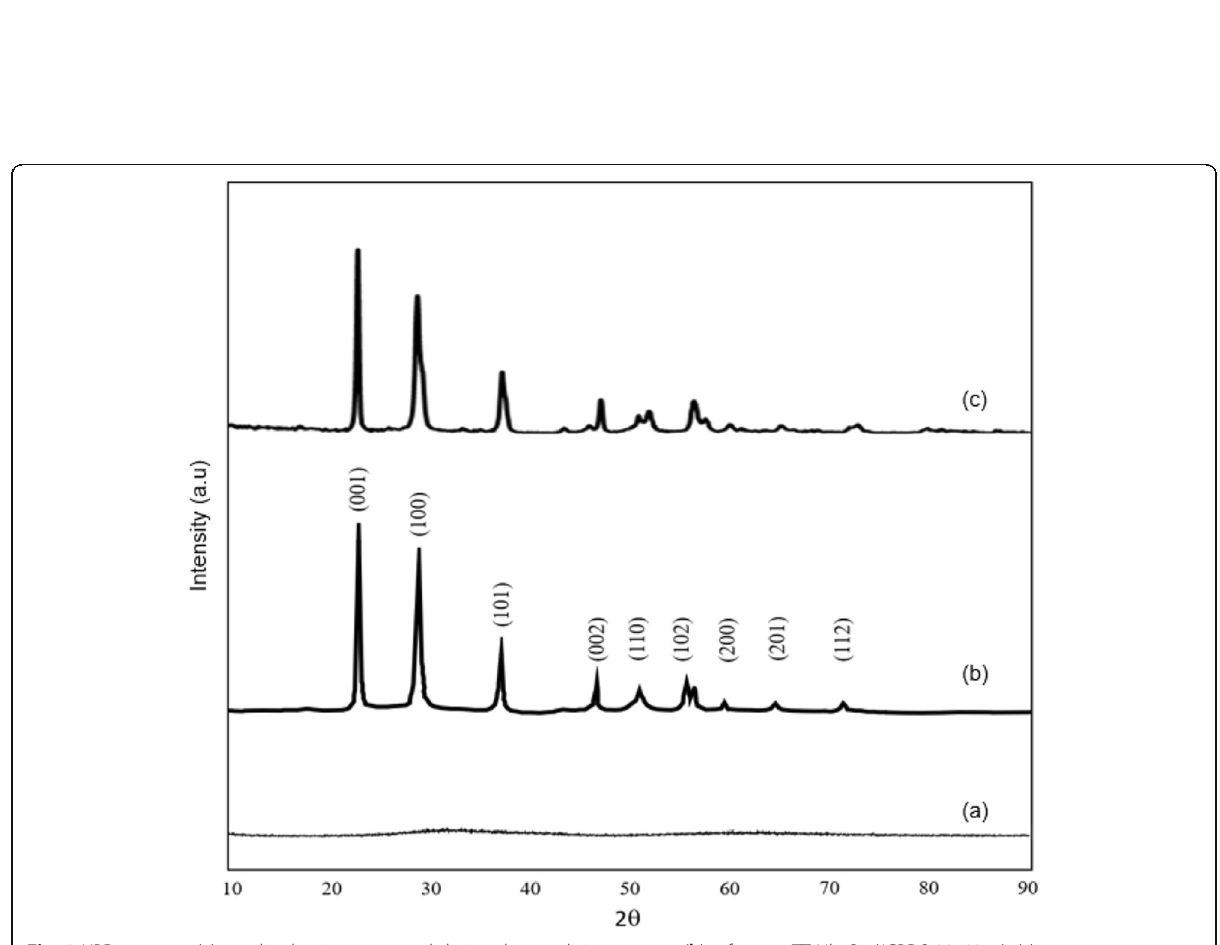
Fig. 2 XRD patterns: ( a ) anodic alumina generated during the anodizing process, ( b ) reference TT-Nb 2 O 5 (JCPDS 28 – 0317), ( c ) Nb 2 O 5 /Al 2 O 3 /Al